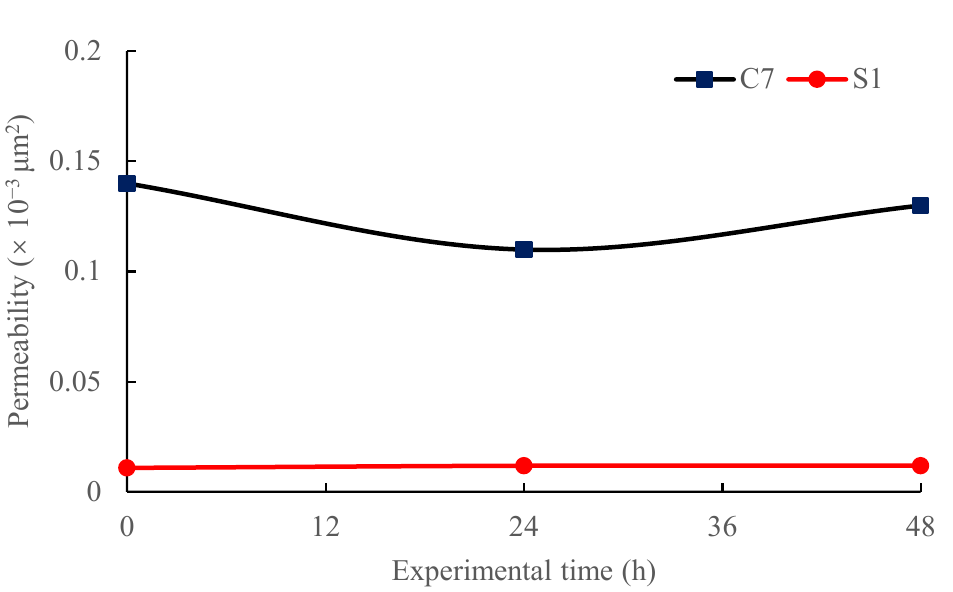
Figure 10. Permeability changes of long-interval (24 h) experiment. The change in porosity for long-interval (24 h) experiments is shown in Figure 11. The porosity of the C7 core decreases at the beginning stage and reaches a minimum value of 2.17% at 24 h and then increases to 3.25% by the end of 48 h. Compared with the initial porosity, the final porosity of the C7 core decreased by 36.5%. After the dissolution, the weakly cemented mineral particles that are released migrate into the core. However, the deposition is greater than the dissolution. Compared with the C7 core, the S1 core has almost no minerals dissolved. The cementation condition is good, and there is almost no migration of weakly cemented minerals. Combined with the static experiment results (Figure 9c,d), it can be considered that the CO 2 -water-rock interaction hardly occurs in the S1 core.